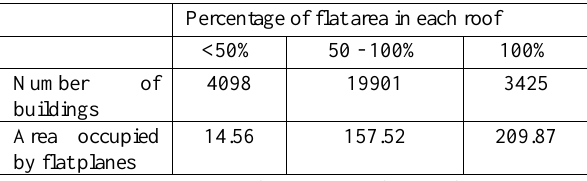
Table 2. Number and area of building roofs classified according to percentage of area occupied by flat plane